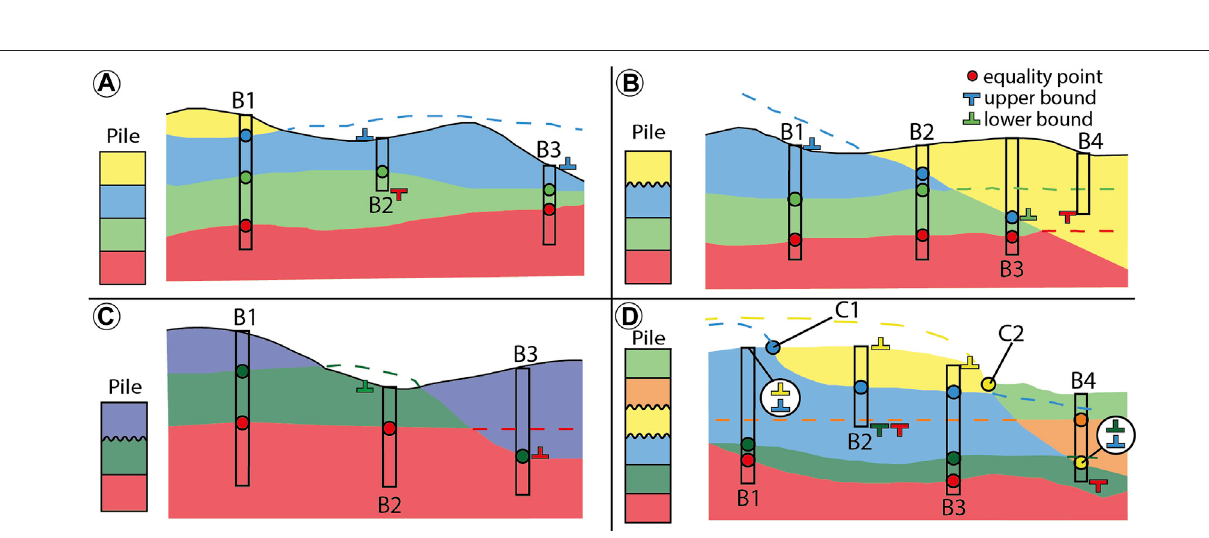
Frontiers in Earth Science |